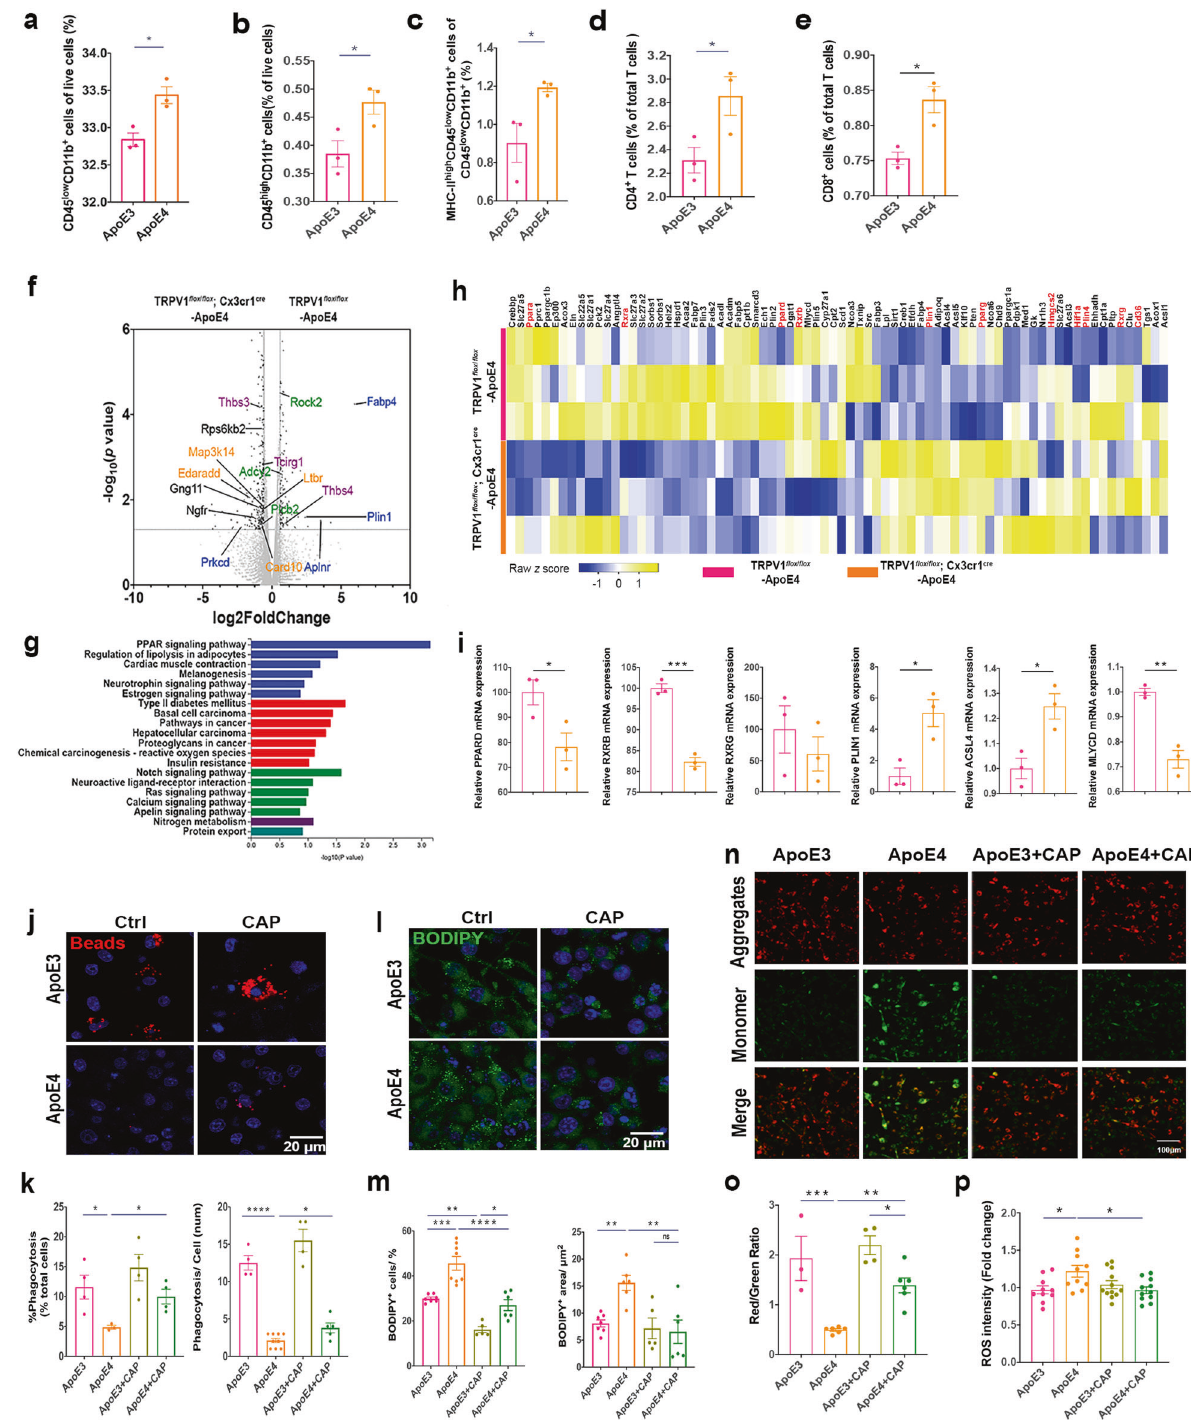
(Fig. 2h). Then, the transcript levels of 78 PPAR target genes were observed, and the results showed that PPARD and retinoic X receptor ( RXRG ) were signi fi cantly downregulated in TRPV1 fl ox/ fl ox ; Cx3cr1 cre -ApoE4 mice compared to those in TRPV1 fl ox/ fl ox -ApoE4 mice (Fig. 2i). PPARG in TRPV1 fl ox/ fl ox ; Cx3cr1 cre -ApoE4 mice also ( PLIN1 and ACSL4 ) were upregulated in TRPV1 fl ox/ fl ox ; Cx3cr1 cre